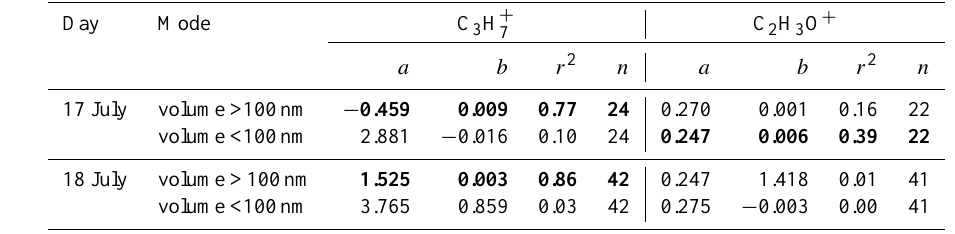
and particle volume 7 correlates with the large mode on both 7